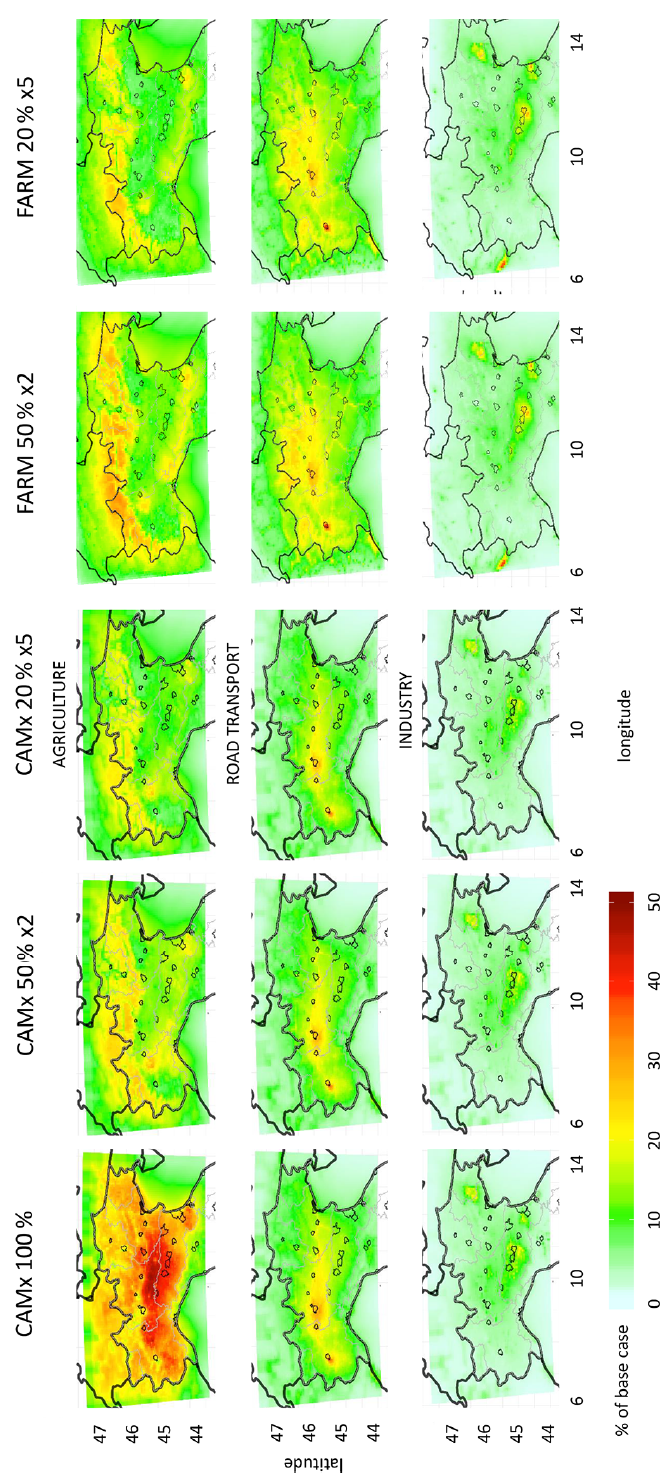
Figure 2. Annual average impacts of AGR, TRA and IND expressed as a percentage of the base case. From left to right: CAMx 100%, 50% and 20% emission reduction levels and FARM 50% and 20% emission reduction levels. For a direct comparison of the linearity between the different ERLs, the impacts of 50% and 20% are multiplied by 2 and 5,